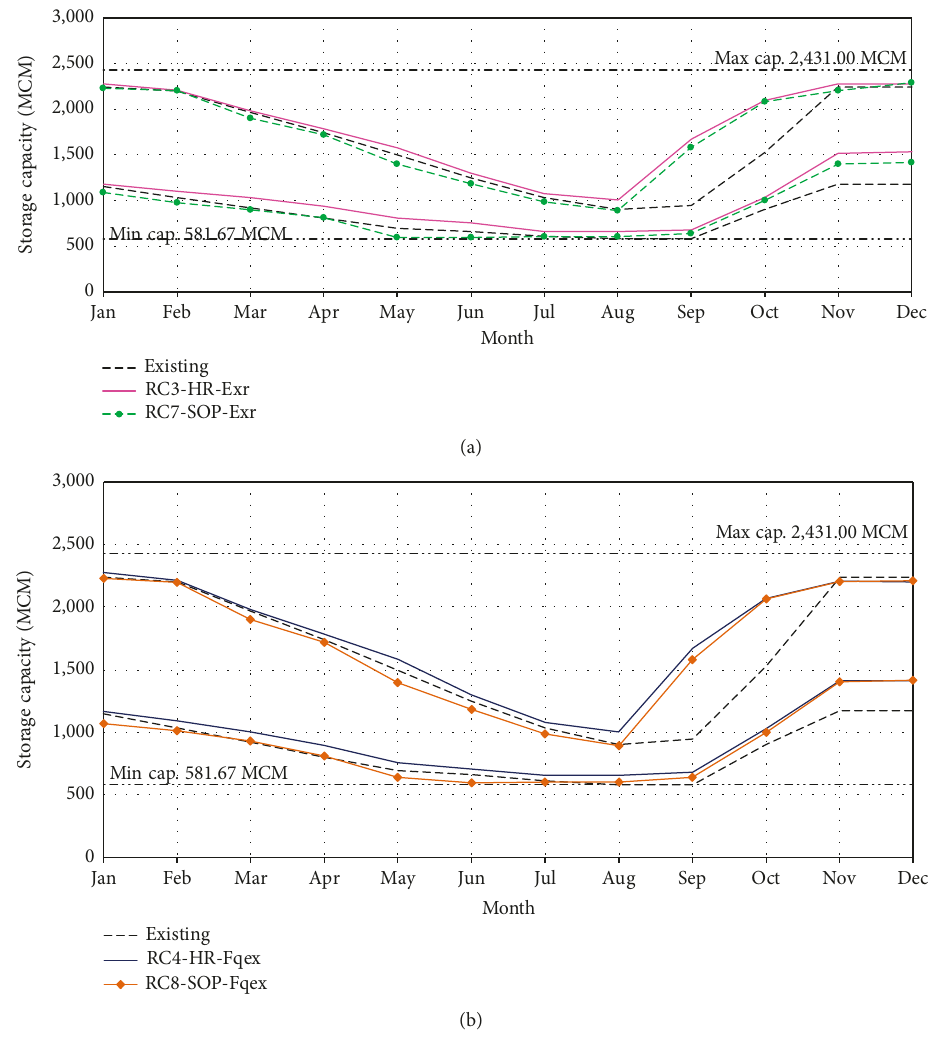
Figure 8: Optimal rule curves of the Ubolratana reservoir considering HR and SOP with objective functions of (a) the minimal average excess water per year and (b) the minimal frequency of excess